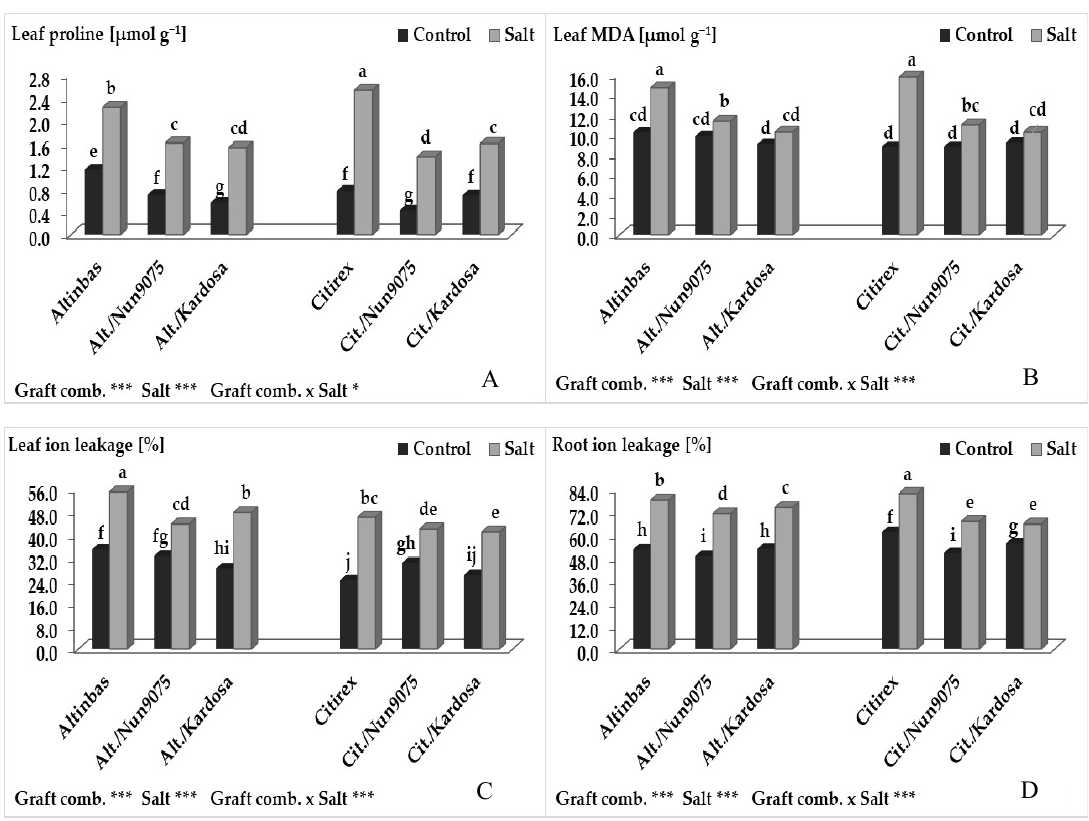
Figure 1. Leaf proline ( A ), malondialdehyde (MDA) ( B ), leaf ion leakage ( C ), and root ion leakage ( D ) of melon graft combinations under control (1.5 dS m − 1 ) and salt stress (8.0 dS m − 1 ) conditions. Values denoted by different letters are significantly different between graft combinations within columns. Significance of main and interaction effects F values: p < 0.05 (*), p < 0.01 (**), and p < 0.001 (***).